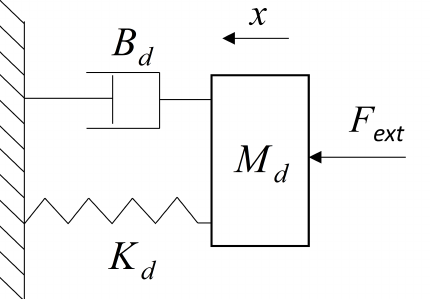
Figure 1. Dynamic model of impedance-control mechanical system.